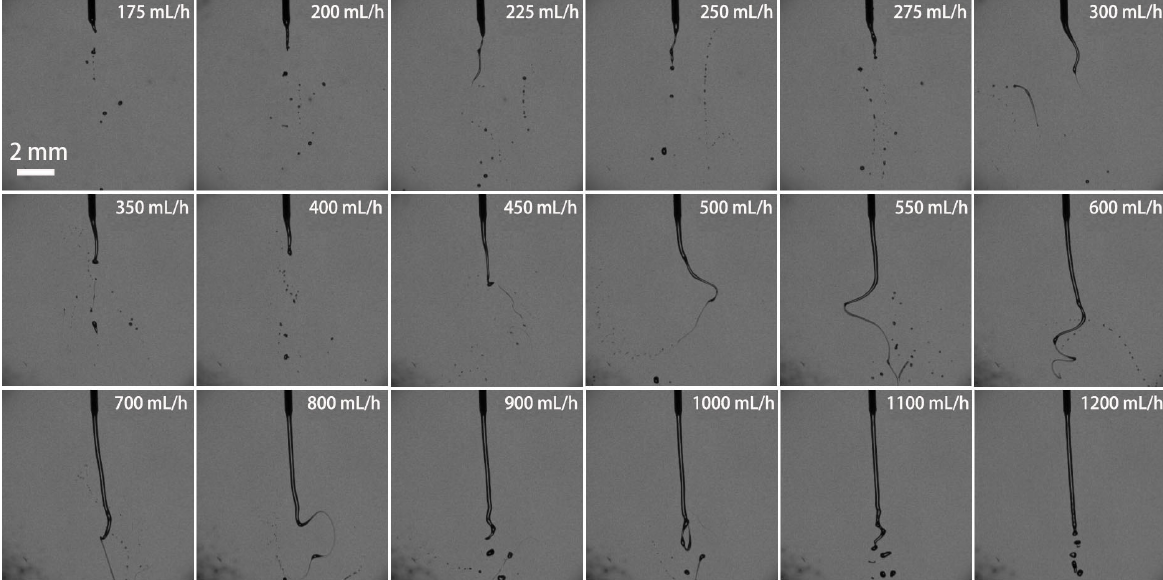
Figure 6. Pictures of electrostatic breakup of H 2 O 2 ligaments and droplet formation at different volume flow rates (21G nozzle, voltage of 28 kV, 35 wt. % concentration).